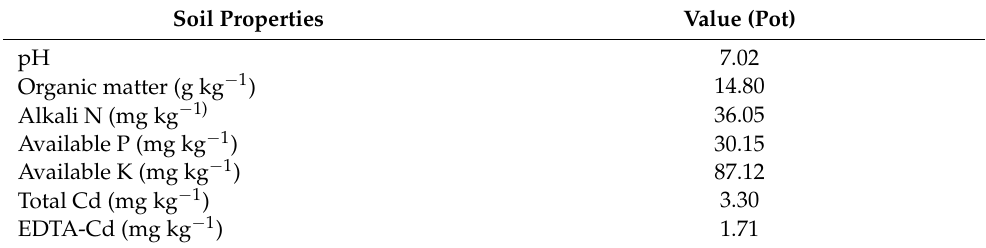
Table 1. Basic properties of the experimental topsoil (0–20